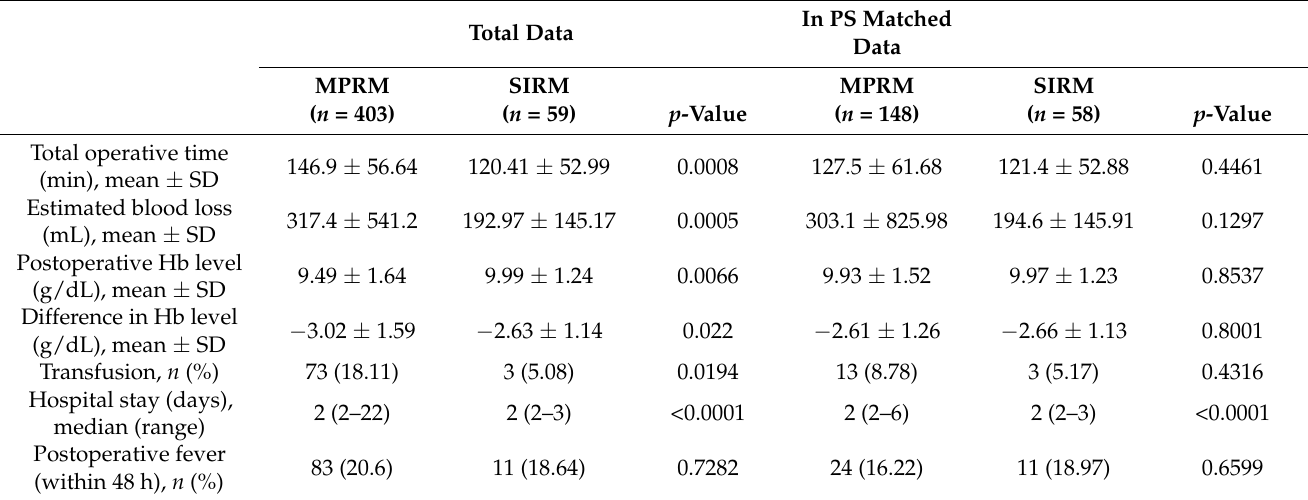
Table 3. Surgical outcomes before and after 1:3 propensity score